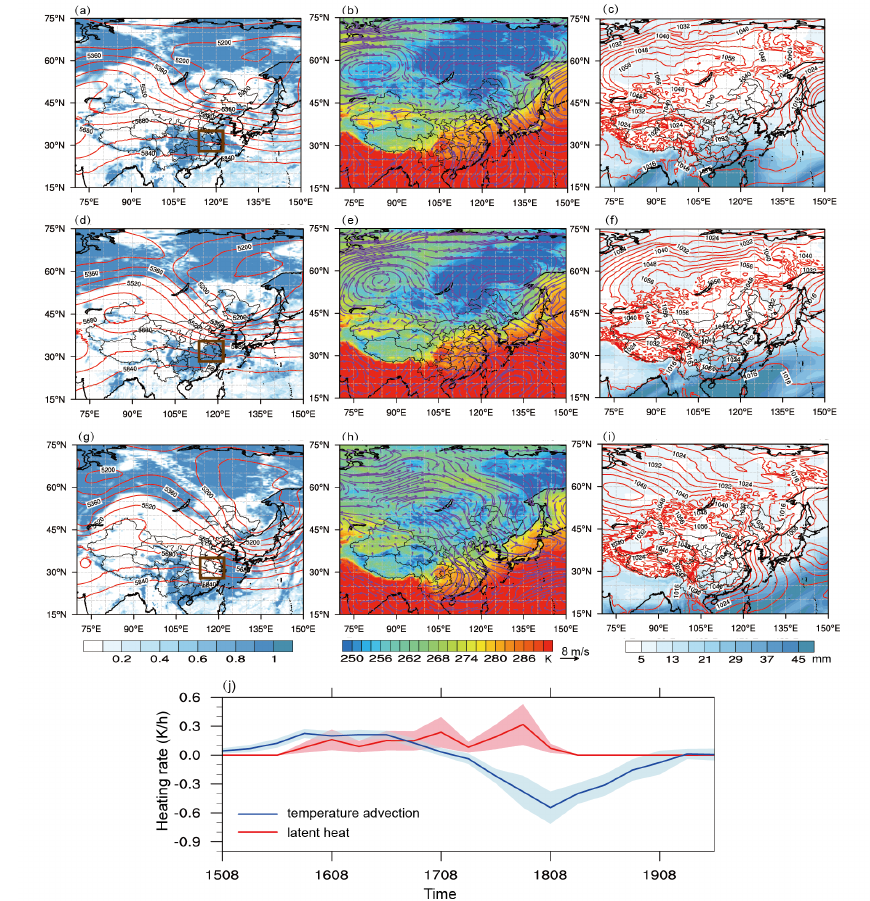
Figure 7. Synoptic analysis of a cold wave case in early winter: ( a ) Cloud cover and 500 hPa geopotential height, ( b ) 2m temperature and 850hPa winds, and ( c ) total precipitable water and SLP at 20 pm on 16 November 2017; ( d – f ) that at 20 pm on 17 November 2017, respectively; and ( g – i ) that at 20 pm on 18 November 2017, respectively. ( j ) The time-series of the mean heating rate caused by 850 hPa temperature advection and latent heat over the brown square in ( a , d , g ).The time coordinate is presented by 4 digits, with the first 2 digits indicating the date in November 2017 and the last 2 digits indicating the local